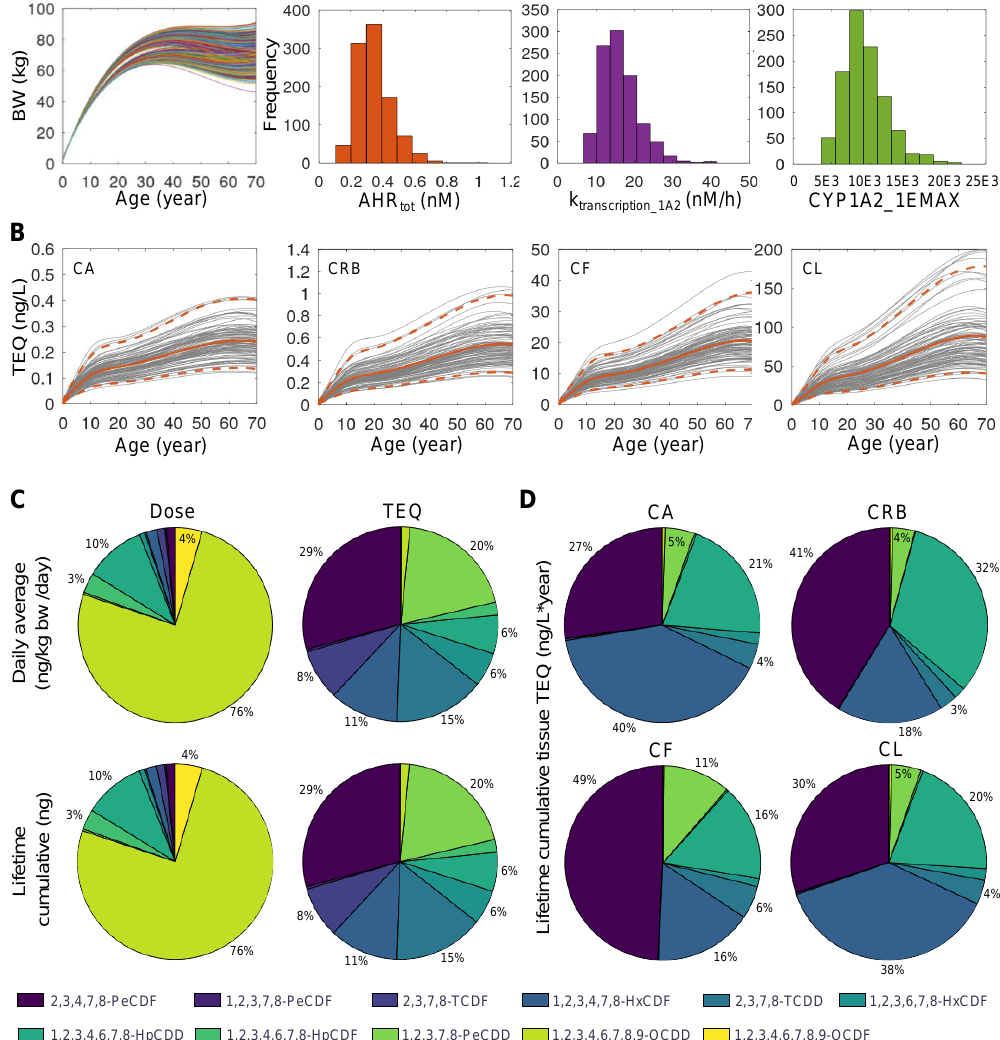
Figure 5. Monte Carlo simulation of 1000 human individuals exposed to 11 DLCs. ( A ) Inter-individual variations in lifetime body weight (BW) changes and three biochemical parameters as indicated. ( B ) The mean (orange solid line) and 2.5 – 97.5 percentile (orange dashed line) levels of blood or tissue TEQ as indicated, overlaid with 100 randomly selected individuals (gray lines). ( C ) Percentage contributions of individual DLC congeners to daily average mass dose (top-left) or lifetime cumulative mass dose (bottom-left) as indicated. Percentage contributions of individual DLC congeners to daily average TEQ (top-right) or lifetime cumulative TEQ (bottom-right) as indicated. ( D ) Percentage contributions of individual DLC congeners to lifetime cumulative blood or tissue TEQ as indicated. The color scheme of the congeners is indicated at the bottom.